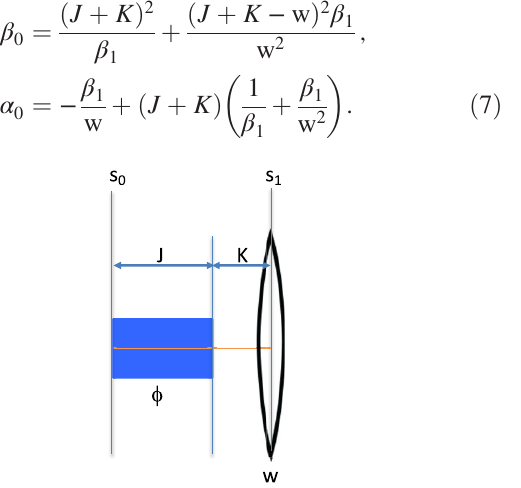
FIG. 4. The form factor of emittance in Eq. (8) as a function of the horizontal beta function at the quadrupole and the distance between the quadrupole and the dipole in the dispersive